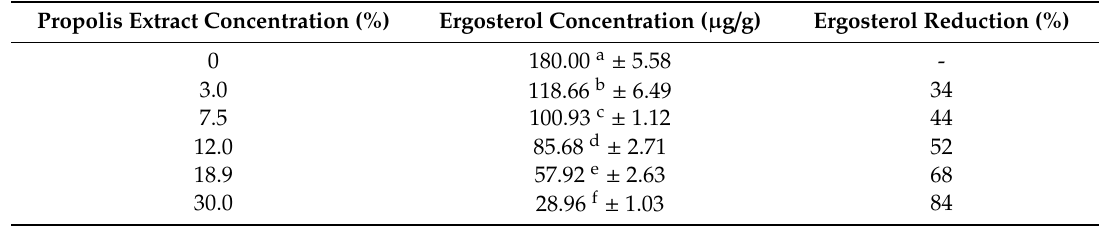
Table 2. Ergosterol concentration and the ergosterol reduction in wood after exposure to C. puteana . Propolis Extract Concentration